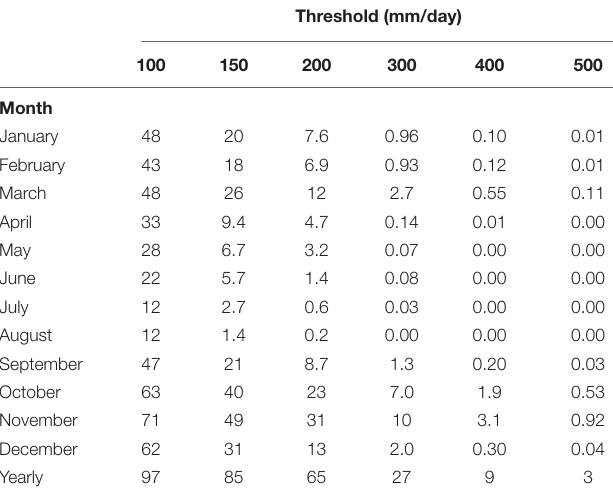
TABLE 5 | Probabilities at different thresholds